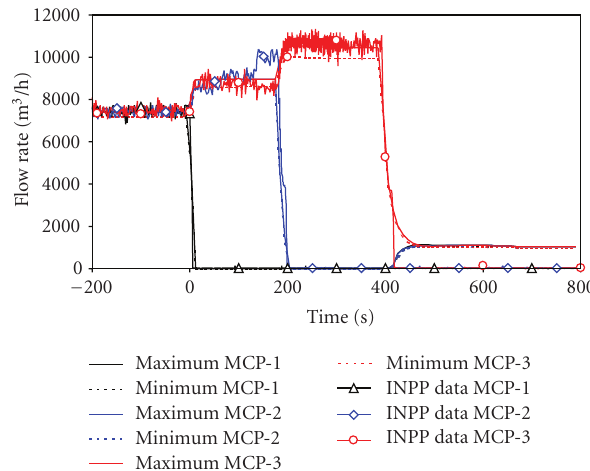
Figure 12: Three MCPs sequential trip. MCPs throughput in the a ff ected MCC loop.